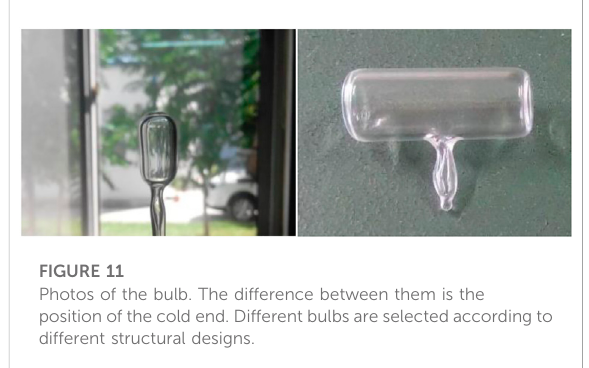
FIGURE 11 Photos of the bulb. The difference between them is the position of the cold end. Different bulbs are selected according to different structural